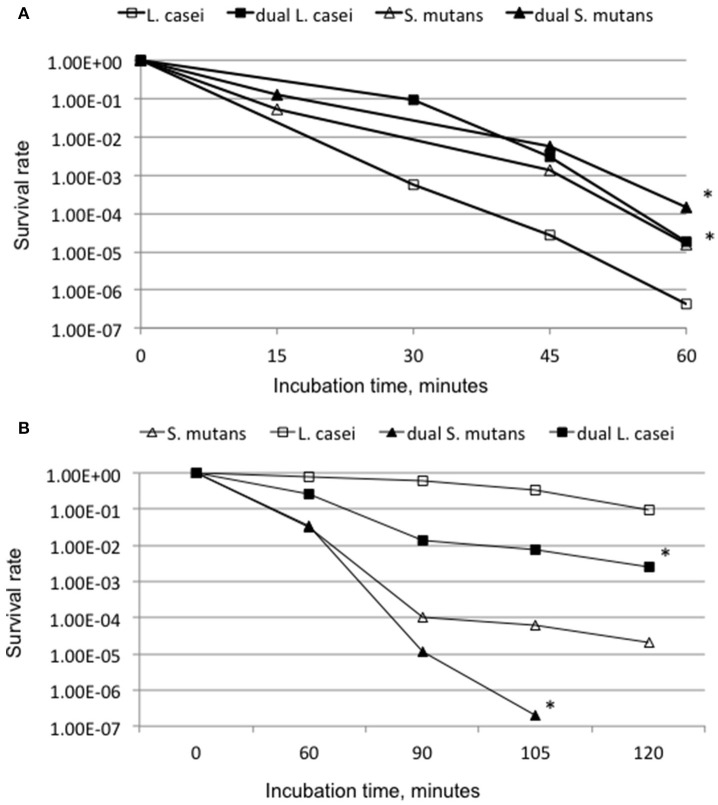
Acid (A) and hydrogen peroxide (B) killing assays. (A) For acid killing, S. mutans, and L. casei biofilms were grown in biofilm medium with glucose and sucrose on glass slides individually or in dual-species for 48 h, and acid killing was carried out at pH 2.0 for L. casei and 2.8 for S. mutans. (B) For hydrogen peroxide killing assays planktonic cultures of S. mutans and L. casei were grown overnight in BHI broth, and killing assays were done in glycine buffer containing 0.2% hydrogen peroxide. Data presented here are representatives of more than three independent assays with * indicating significant difference at P < 0.001 in comparison to the respective mono-species cultures.